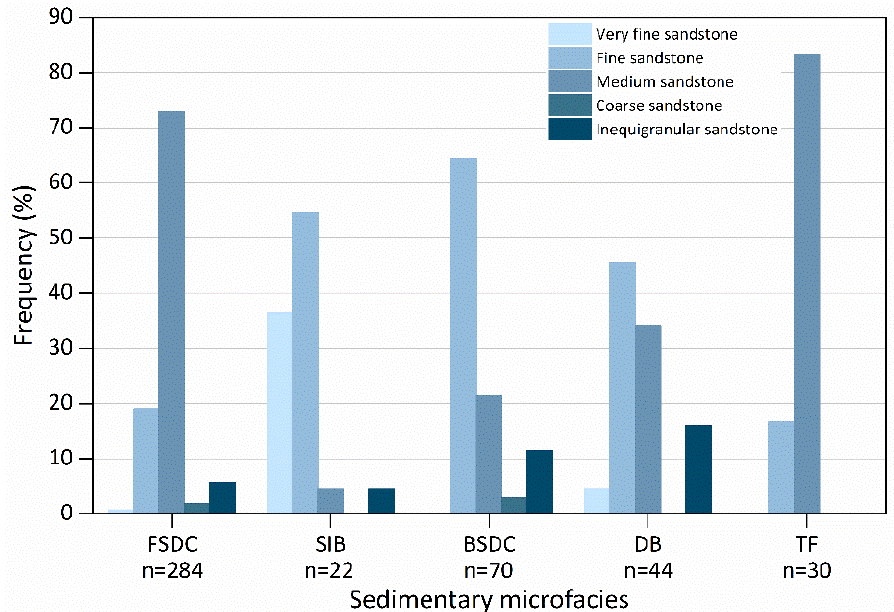
Figure 6. Lithology distribution of sandstones from each sedimentary microfacies, where “n” is the number of samples. (FSDC — submerged distributary channel (fan delta), SIB — submerged interdistributary bay, BSDC — submerged distributary channels (braided delta), DB — distal bar, TF — turbidite fan).